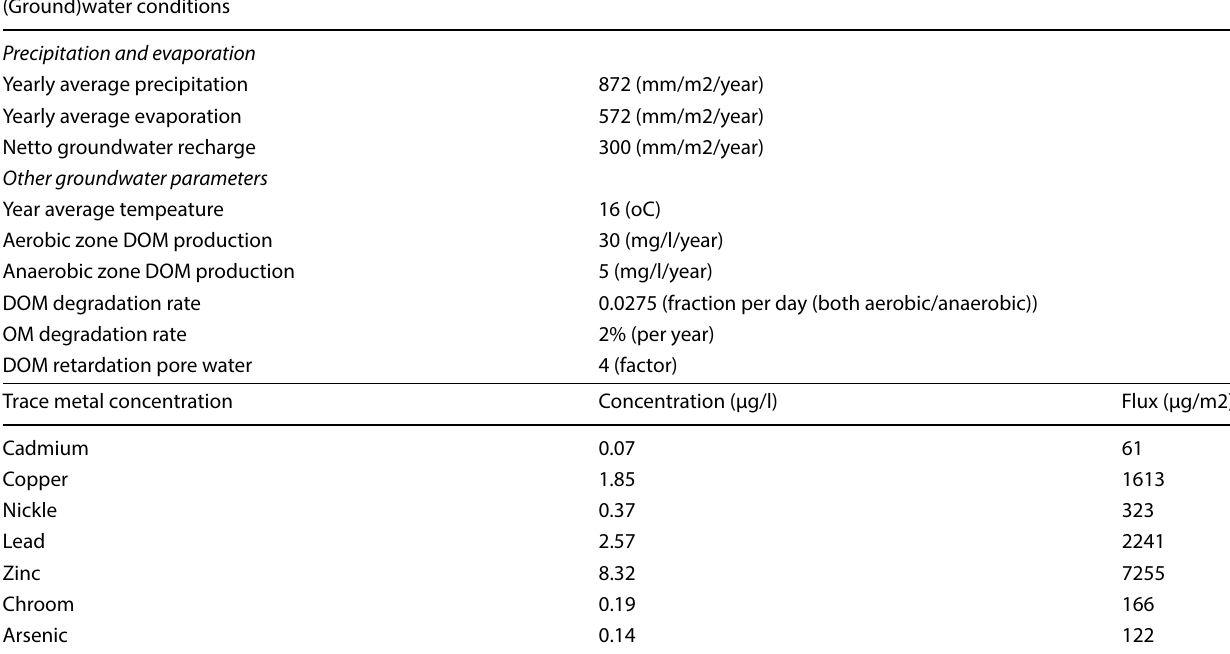
Table 3 (Ground)water conditions (Ground)water